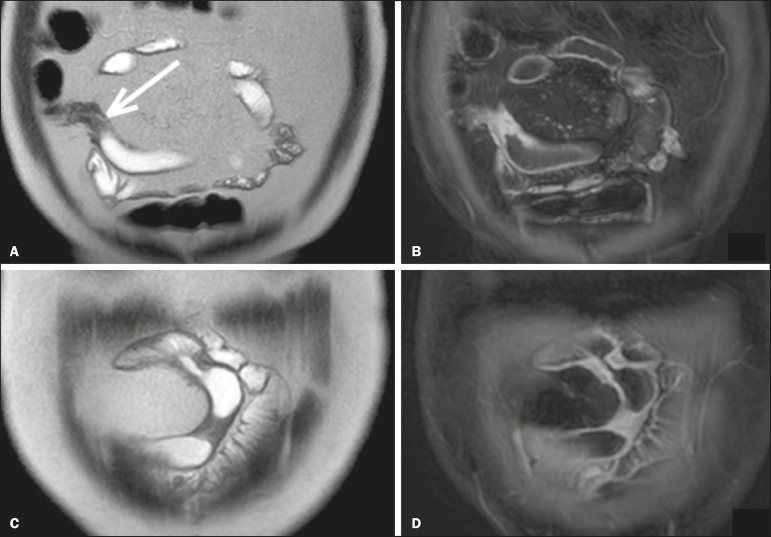
Coronal T2-weighted MRE sequence (A,B) and coronal, paramagnetic contrast-enhanced, fat-saturated T1-weighted MRE sequence (C,D) showing signs of fibrosis and mild stenosis (arrow) in the distal ileum (A,C) and inflammatory activity in the medium ileum (B,D). Also note the use of the biphasic oral contrast (polyethylene glycol) distending the intestinal lumen, with high signal intensity in the T2-weighted sequence and low signal intensity in the T1-weighted sequence.